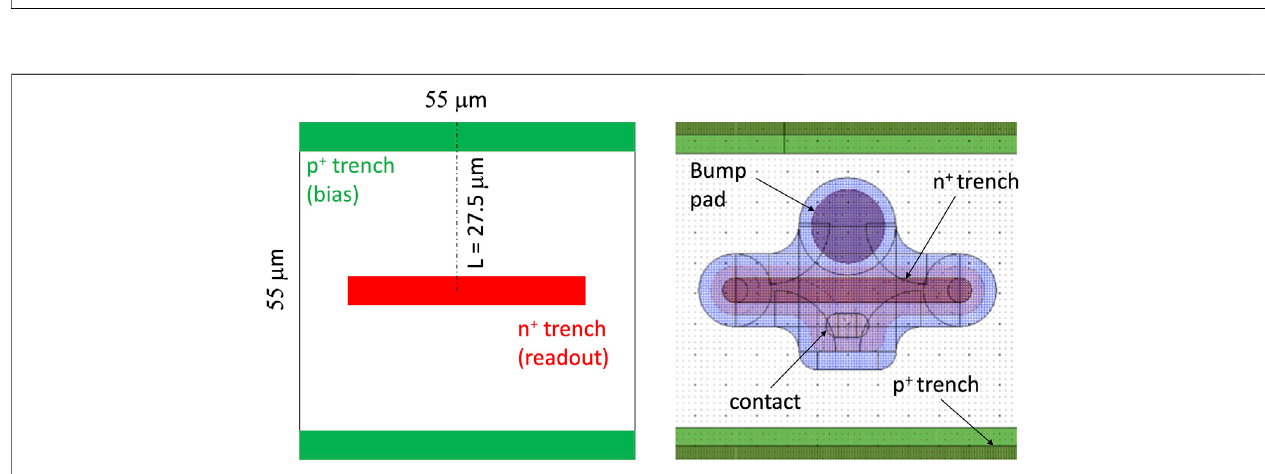
FIGURE 3 | Layout of small-pitch 3D pixels for the ATLAS and CMS upgrades at HL-LHC (two adjacent pixels are shown in each slice). (A) 50 × 50 – 1E; (B) 25 × 100 – 1E; (C) 25 × 100 – 2E (D) 25 × 100 – 2E (V-ear); (E) 25 × 100 – 2E